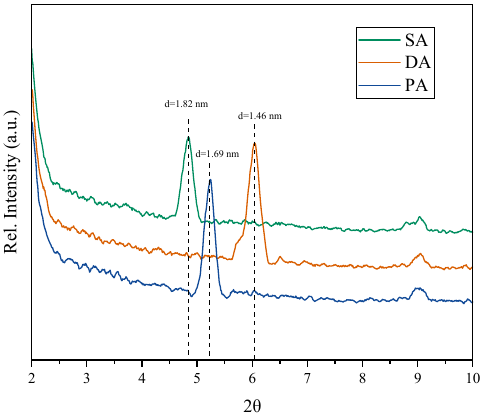
Figure 7. XRD pattern of Na-Mmt under different addition methods.